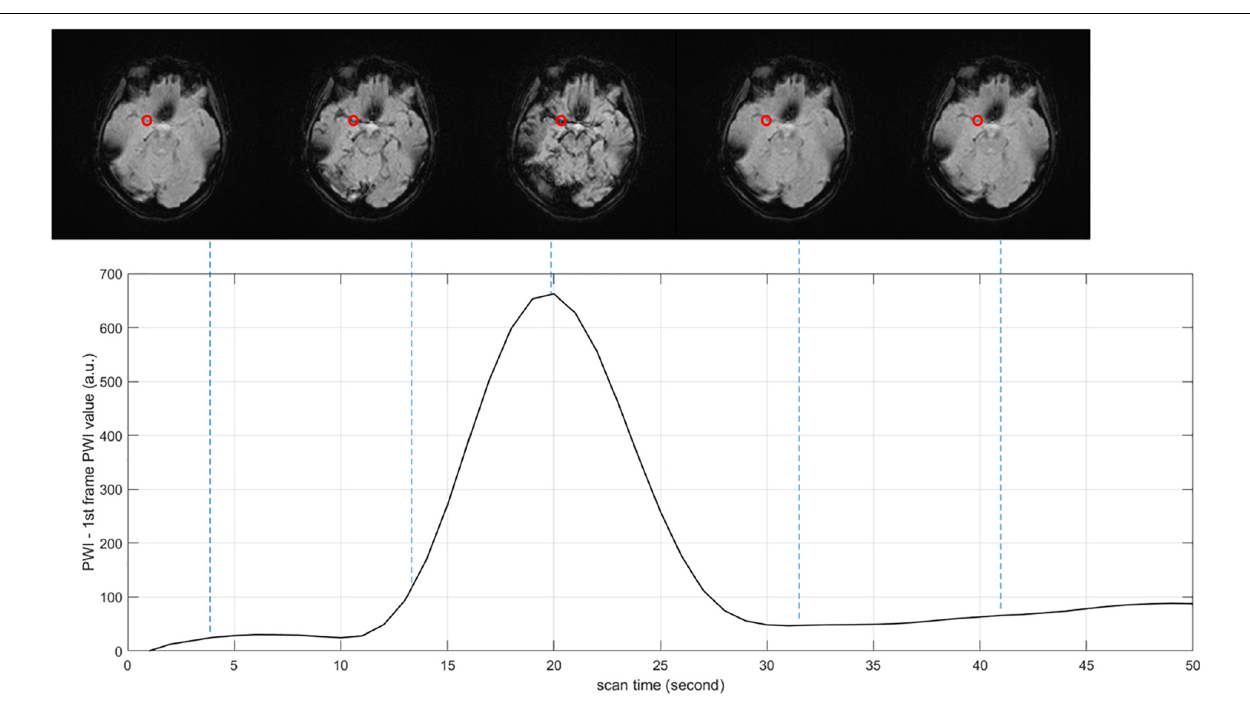
diffusion coefficient (ADC) is less than 620, the corresponding region is defined as an infract core in our application. The ischemic region beyond the infarct core is considered to be